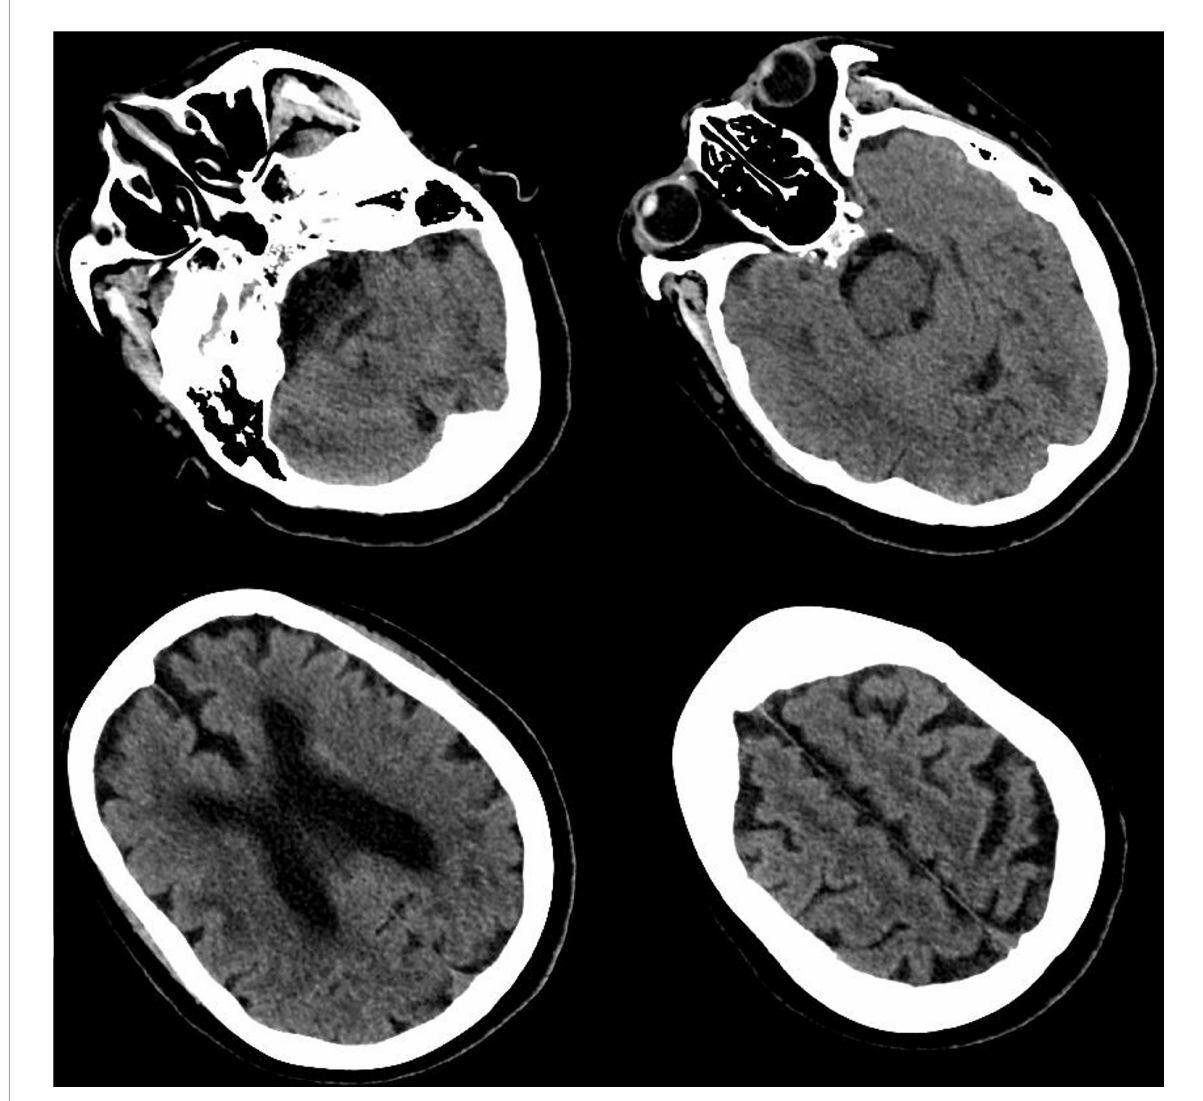
FIGURE1 Cranial computed tomography (CT) scan. CT scan showed multiple cerebral infarction, white matter degeneration, brain atrophy, with no sign of cerebral hemorrhage or space-occupying